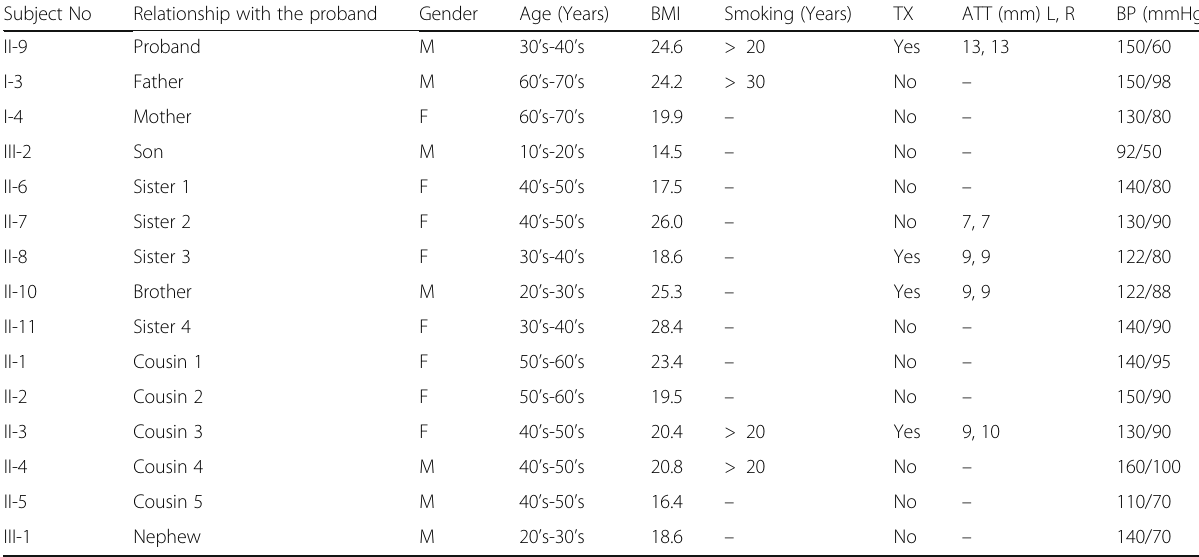
Table 2 Demographics and clinical characteristics of all subjects